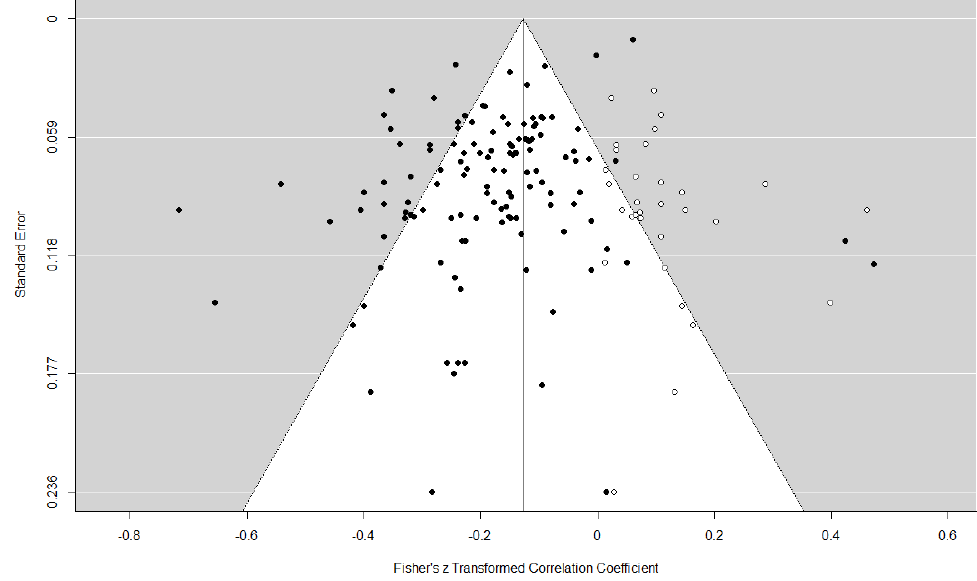
Figure 2. Funnel plot of publication bias. The closed dots indicate the observed studies, and the open dots indicate the missing studies imputed by trim-and-fill method (based on the estimator L 0 ).